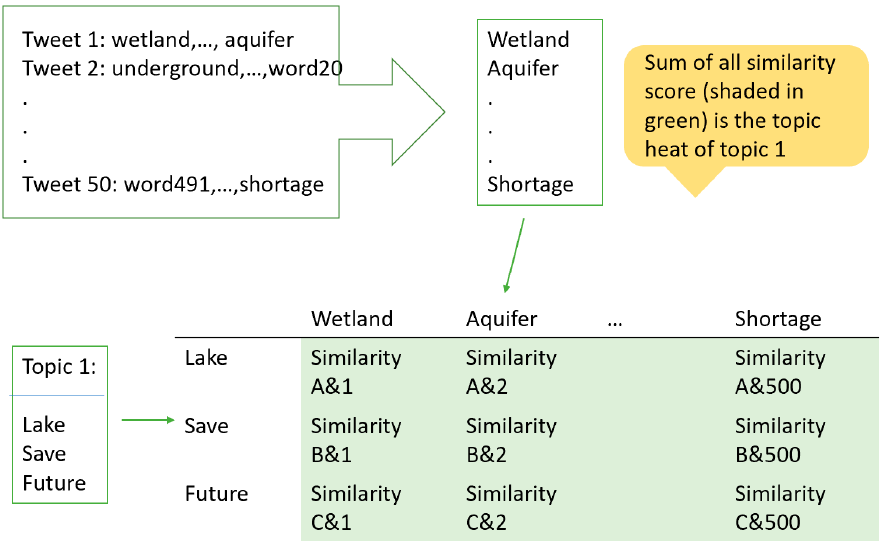
Figure 1. Calculation of topic heat for a given topic.